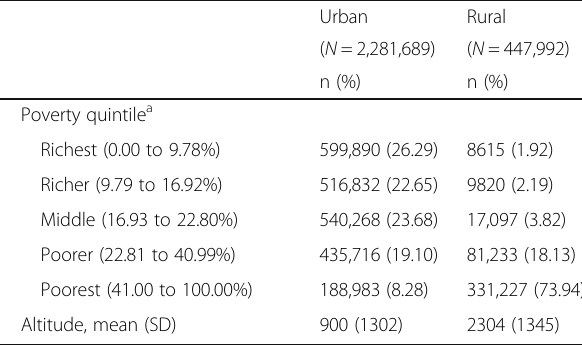
Table 1 Characteristics of the births in Peru, July 2005 – April